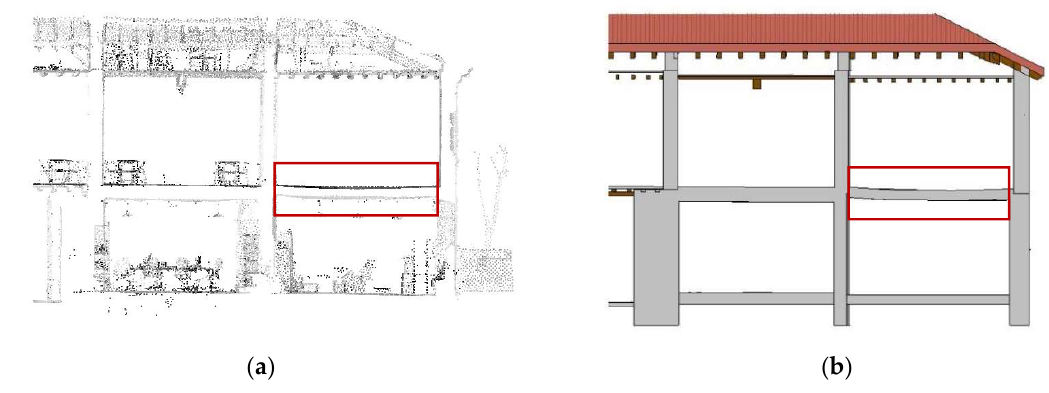
Figure 7. Example of survey of a flexural anomaly in a floor beam ( a ) laser scanner survey; ( b ) section redrawing.